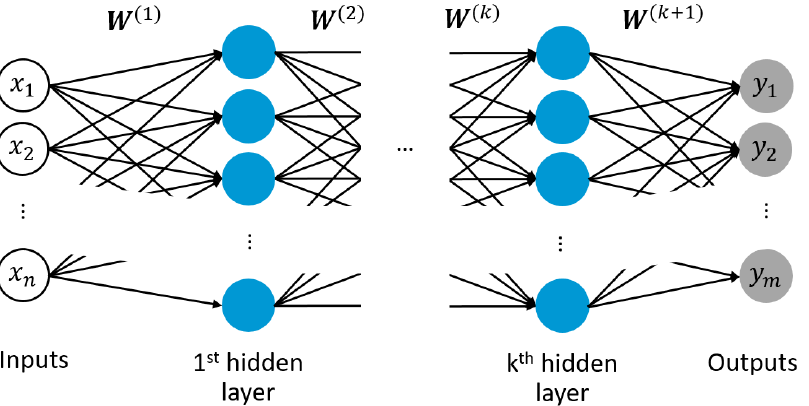
Figure 4. Schematic of a multi-layered neural network with input layer, k hidden layer and output layer, including weight vectors W of edge connections between neurons of adjacent layers for correlating n number of inputs [ x 1 , x 2 , . . . , x n ] to m number of outputs [ y 1 , y 2 , . . . , y m ] .